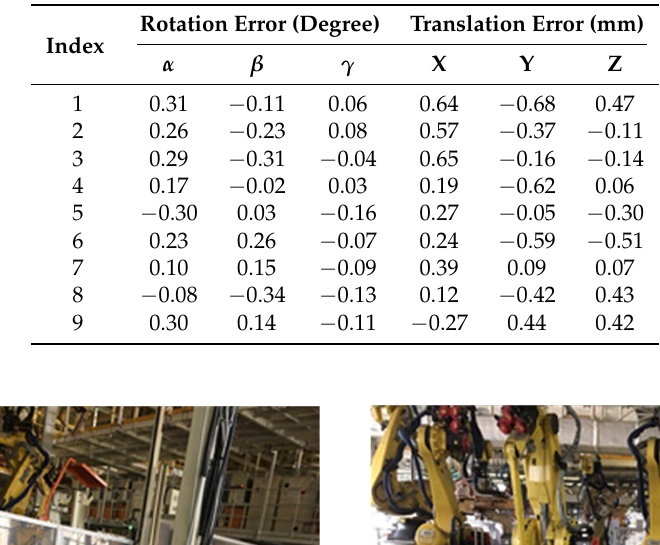
Table 1. Pose estimation errors (rotation and translation) compared between proposed method and robot teaching (seen as ground-truth).